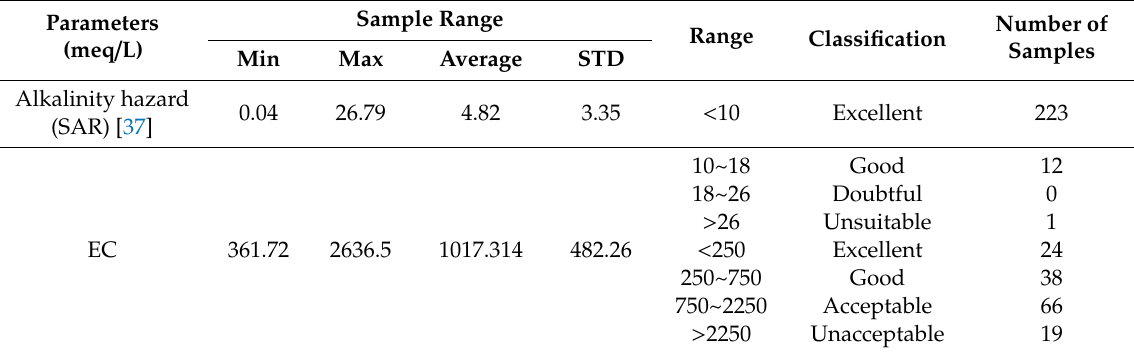
Table 2. Classification of groundwater samples of the study area for irrigation